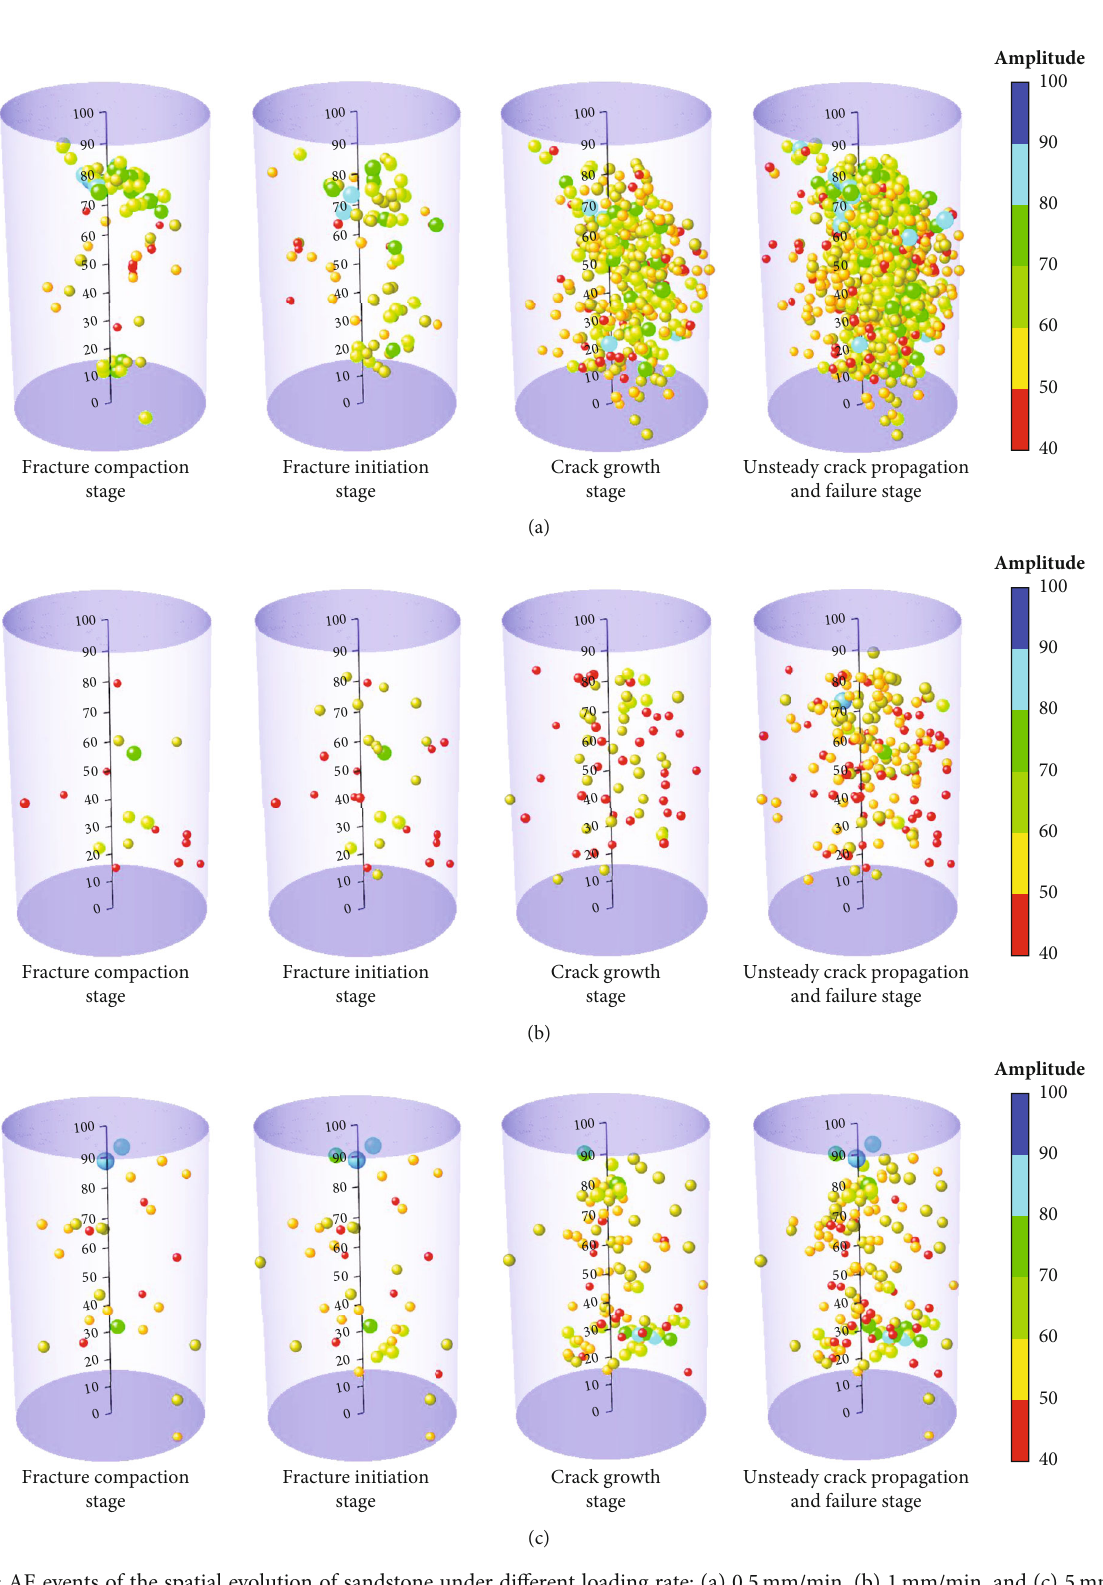
Figure 9: AE events of the spatial evolution of sandstone under di ff erent loading rate: (a) 0.5mm/min, (b) 1 mm/min, and (c) 5